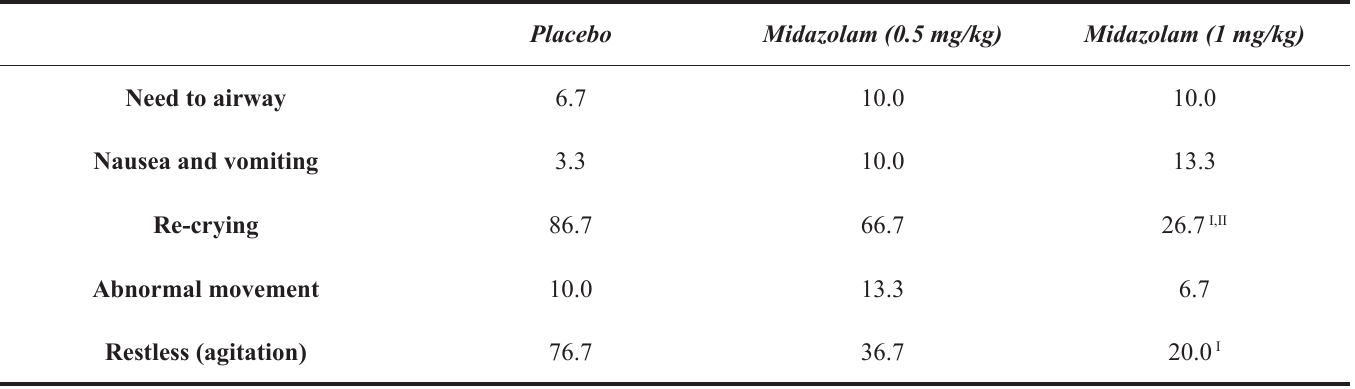
I Kruskal-Wallis statistically significant between three group, P<0.001 II Mann-Whitney U statistically significant between the midazolam groups, P<0.01 Adverse events after the operation in the three groups are shown in Table 4. TABLE 4 - Adverse events after the operation in children randomly allocated to receive premedication with midazolam or